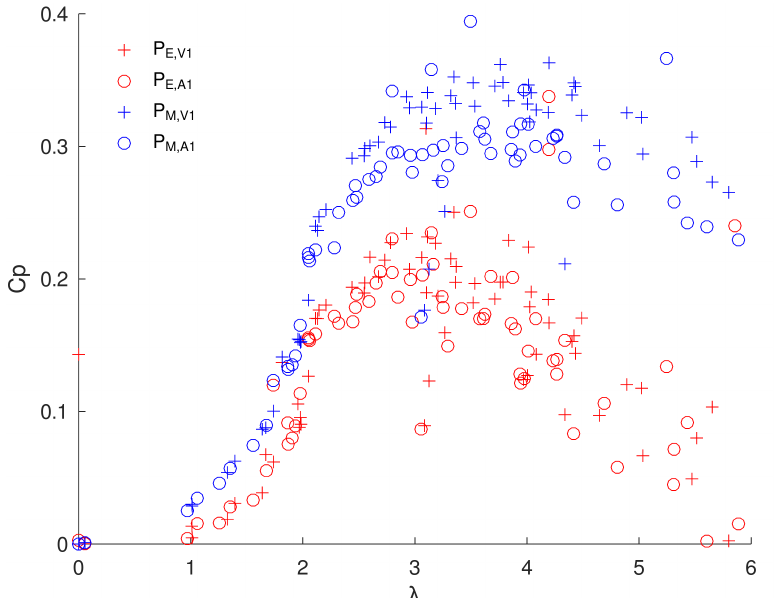
Figure 5. C p – λ data for all runs performed in the field, with no filtering applied. Power is based on electrical ( P E ) or mechanical ( P M ) data, inflow is measured using mean x velocity u for the Vector 1 or depth averaged velocity (DAV) data over all bins for the Aquadopp 1.